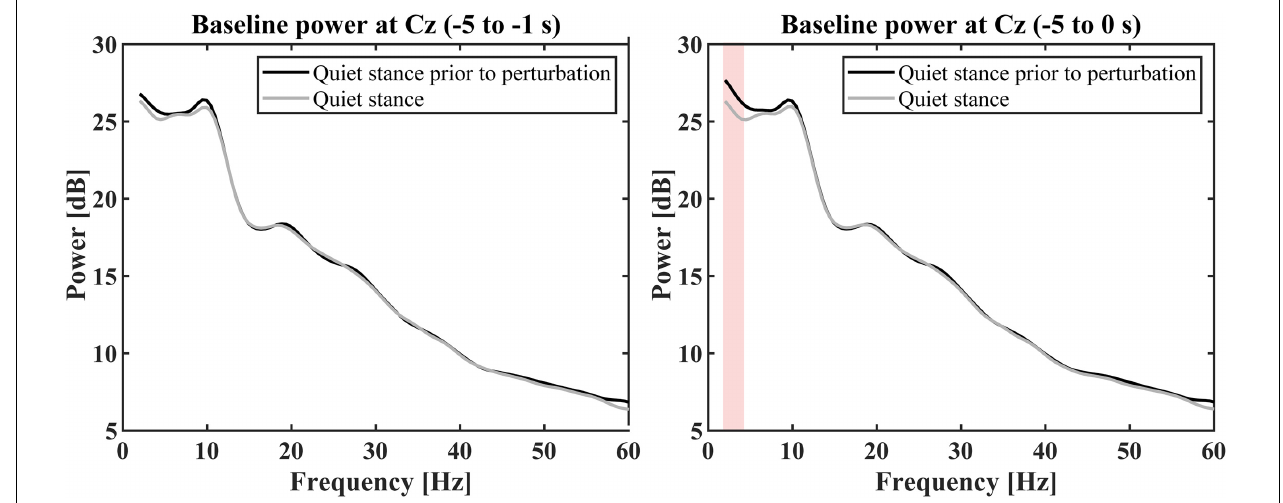
FIGURE 6 | Grand average baseline power spectra in quiet stance prior to perturbation (black curve) and quiet stance (gray curve). The left panel shows the average power calculated from –5 to –1 s before the perturbation. There was no significant difference between the baseline of perturbed conditions and the quiet stance power spectrum ( p < 0.05). The right panel shows the average power calculated from –5 to 0 s before the perturbation. There was no significant difference between the baseline in perturbation conditions and the quiet stance power spectrum, except for powers from 2 to 4.5 Hz (red color shaded area, p <